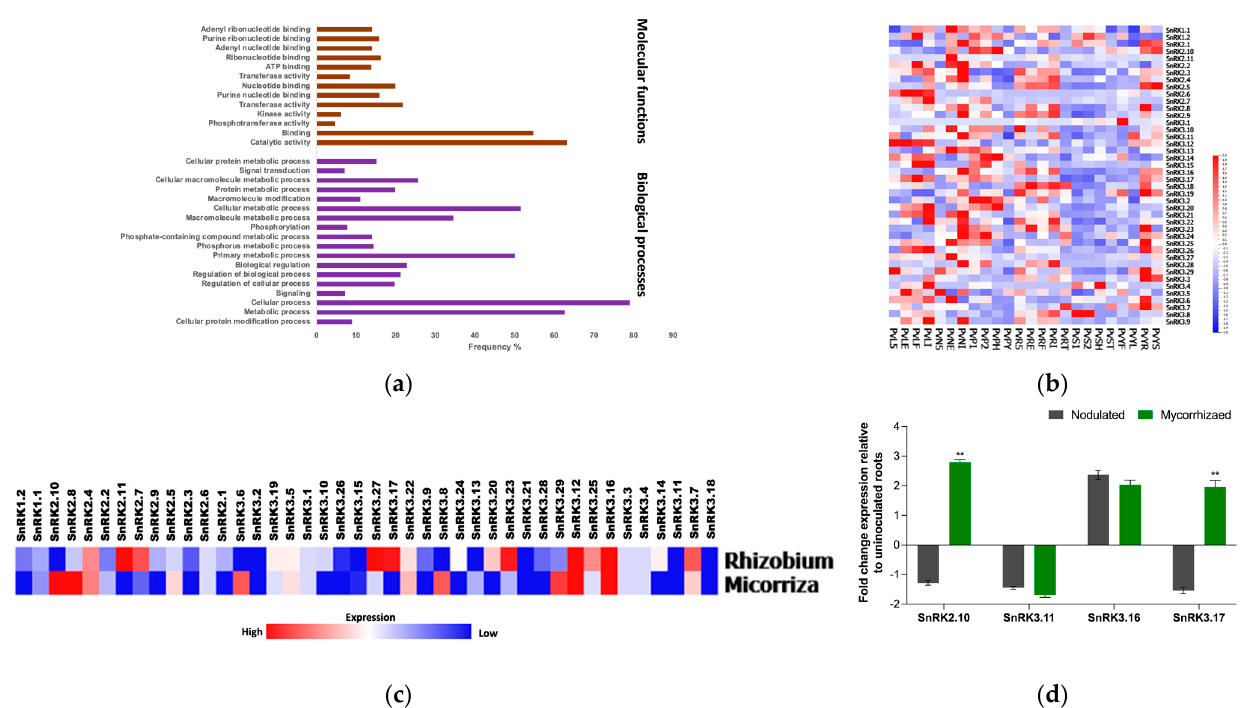
Figure 6. Gene Ontology and in silico expression analysis of SnRK genes. ( a ) Gene Ontology enrich- ment analysis of molecular analysis and biological processes for the members of Phaseolus SnRK genes. ( b ) Tissue-specific expression profiles of Phaseolus SnRK s. Heat map expression profiles of SnRK genes in various Phaseolus tissues. The transcriptome data across different tissues were extracted from the P. vulgaris gene expression atlas ( Pv GEA). ( c ) Heat maps showing PvSnRK gene expression patterns specific to AM and rhizobial colonization. Colour bar shows the fold-change range, with red and blue representing upregulation and downregulation, respectively. The heat map was generated by R using the Fragments per kilobase of exon model per million reads mapped (FPKM) values of each SnRK gene. ( d ) RT-qPCR analysis showing relative expression of Phaseolus SnRK2.10 , SnRK3.11 , SnRK3.16 , and SnRK3.17 genes. Candidate genes were selected and corre- sponding transcript accumulation under mycorrhized and nodulated conditions was quantified by RT-qPCR. RT-qPCR data are the averages of three biological replicates (n > 9). The statistical signif- icance of differences between mycorrhized and nodulated roots was determined using an unpaired two-tailed Student’s t -test (** p < 0.01). Error bars represent means ± Standard error mean (SEM).